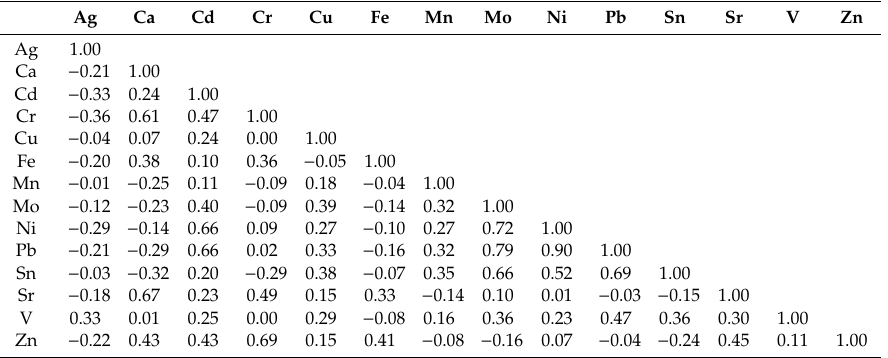
− 0.80 0.21 − 0.19 − 0.23 − 0.20 − 0.14